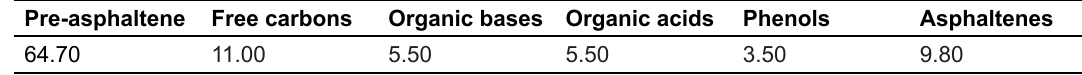
Table 10. Chemical composition in group organic compounds of pyrolysed tar Pre-asphaltene Free